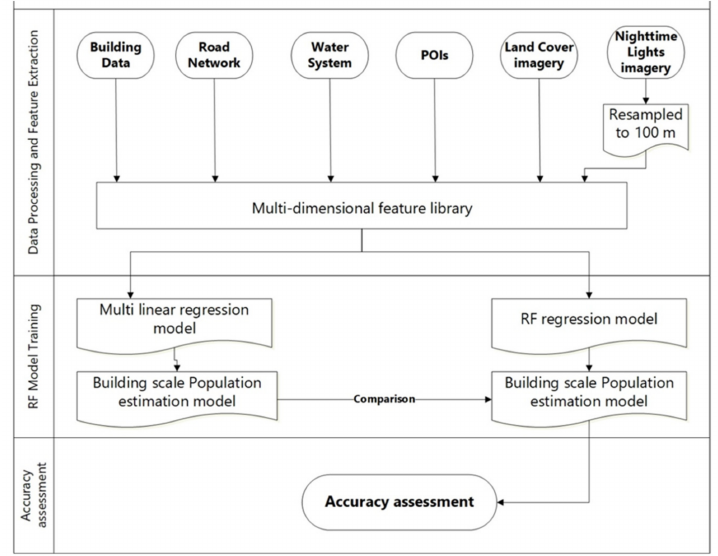
Figure 4. Flowchart of RF model construction and accuracy